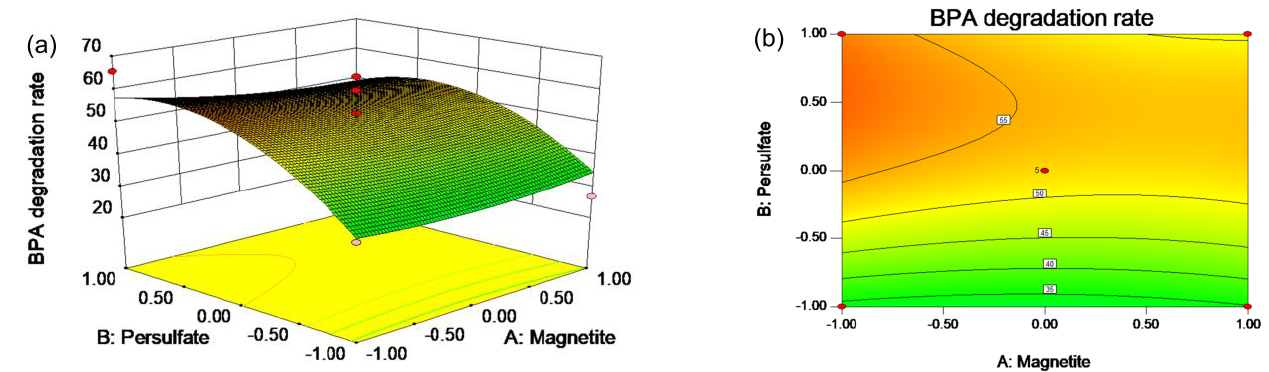
Figure 8. Response surface plot of PS and magnetite on BPA removal. (a) Three-dimensional plot; (b) Two-dimensional plot. [BPA] = 5 mg/L, [magnetite] = 0.1 g/L, pH = 5.0, T = 20 °C.